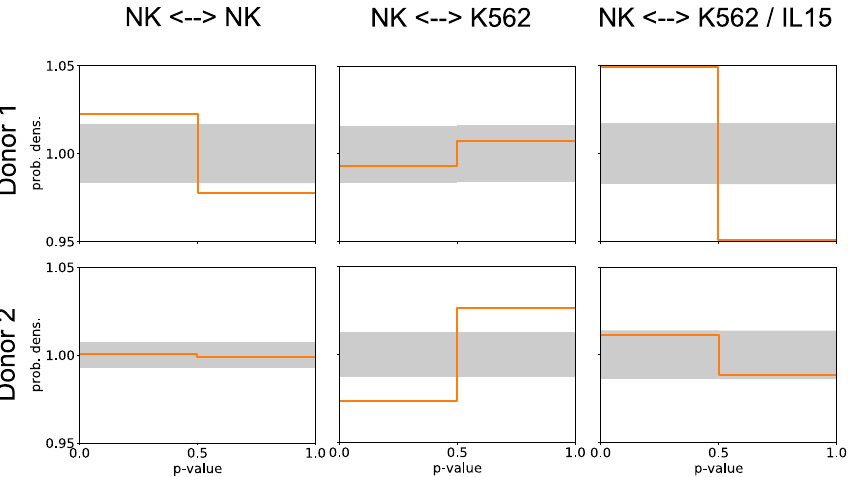
Figure 6. p value distributions of NK cells in a thick collagen gel. Shown are the interactions between NK cells and other NK cells (left column), between NK and wild-type K562 cells (center column), and between NK and K562 cells that secret the chemokine IL-15 (right column). Identical experiments have been performed using NK cells from two different donors (rows). To improve the statistics, the histograms have been computed with only two bins. For donor 1, we find (weak) attractive interactions between NK cells and strong attractive interactions between NK and IL-15-secreting K562 cells. For donor 2, we find repulsive interactions between NK and wild-type K562